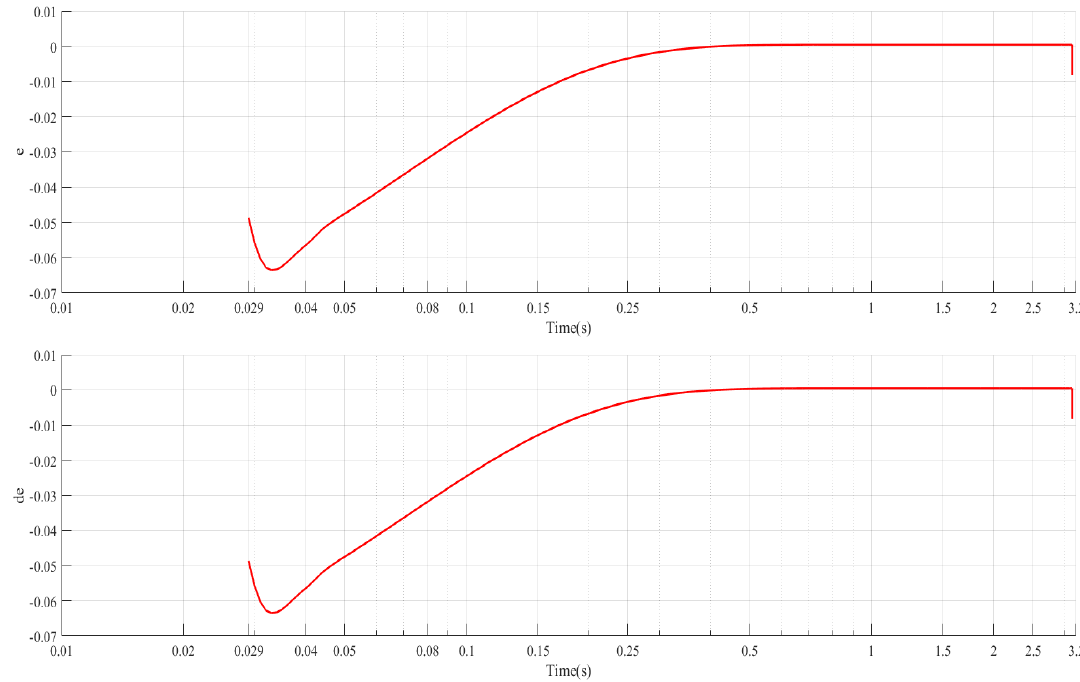
Figure 12. The wheel slip ratio error: e = λ o − λ t and de with adaptive capability.